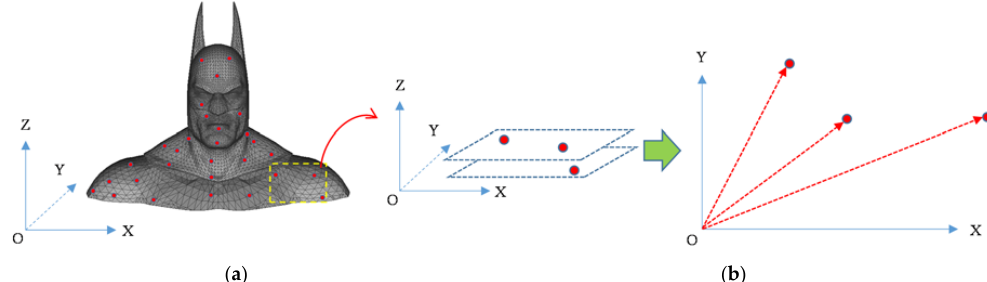
Figure 4. ( a ) Feature points in OXYZ space; and ( b ) feature points in OXY space.